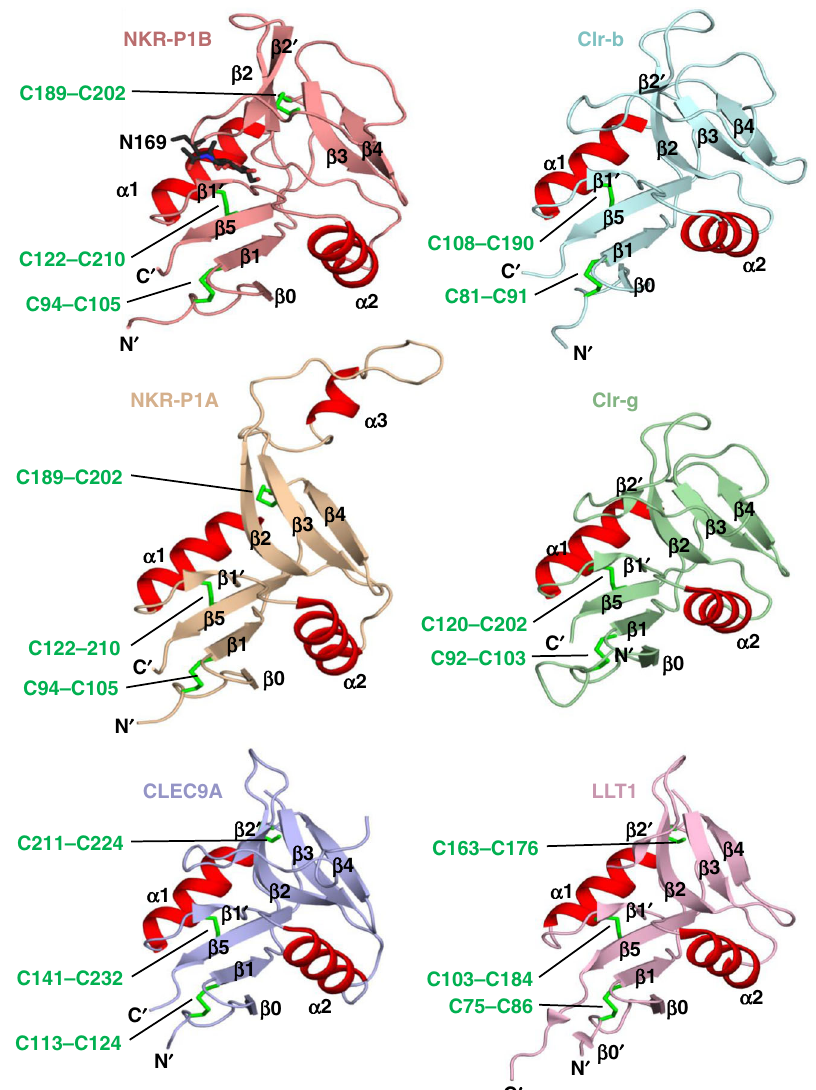
Fig. 1 The CTLD fold of NKR-P1B and Clr-b. Comparison of the structures of NKR-P1B and Clr-b with other related receptors and ligands including mouse NKR-P1A (PDB ID: 3M9Z), Clr-g (PDB ID: 3RS1), CLEC9A (PDB ID: 3VPP) and LLT1 (PDB ID 4QKG). α -helices are shown in red and disul fi de bonds are represented as green sticks. The single GlcNAc moiety attached to Asn169 of NKR-P1B is shown as